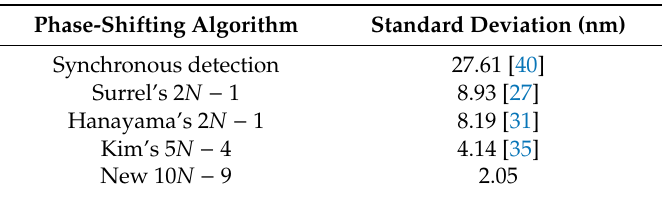
Table 3. Standard deviations of